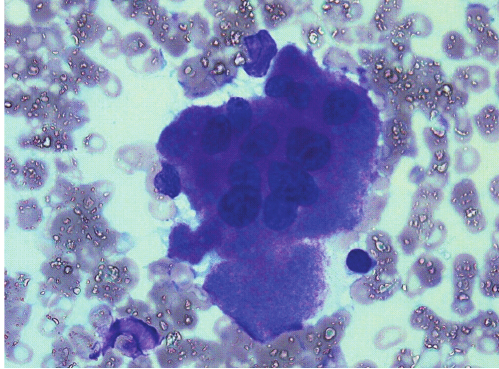
Figure 3: Marked megakaryocyte nuclear fragmentation, Bone marrow aspirate, ICSH Romanovsky stain × 1,000.